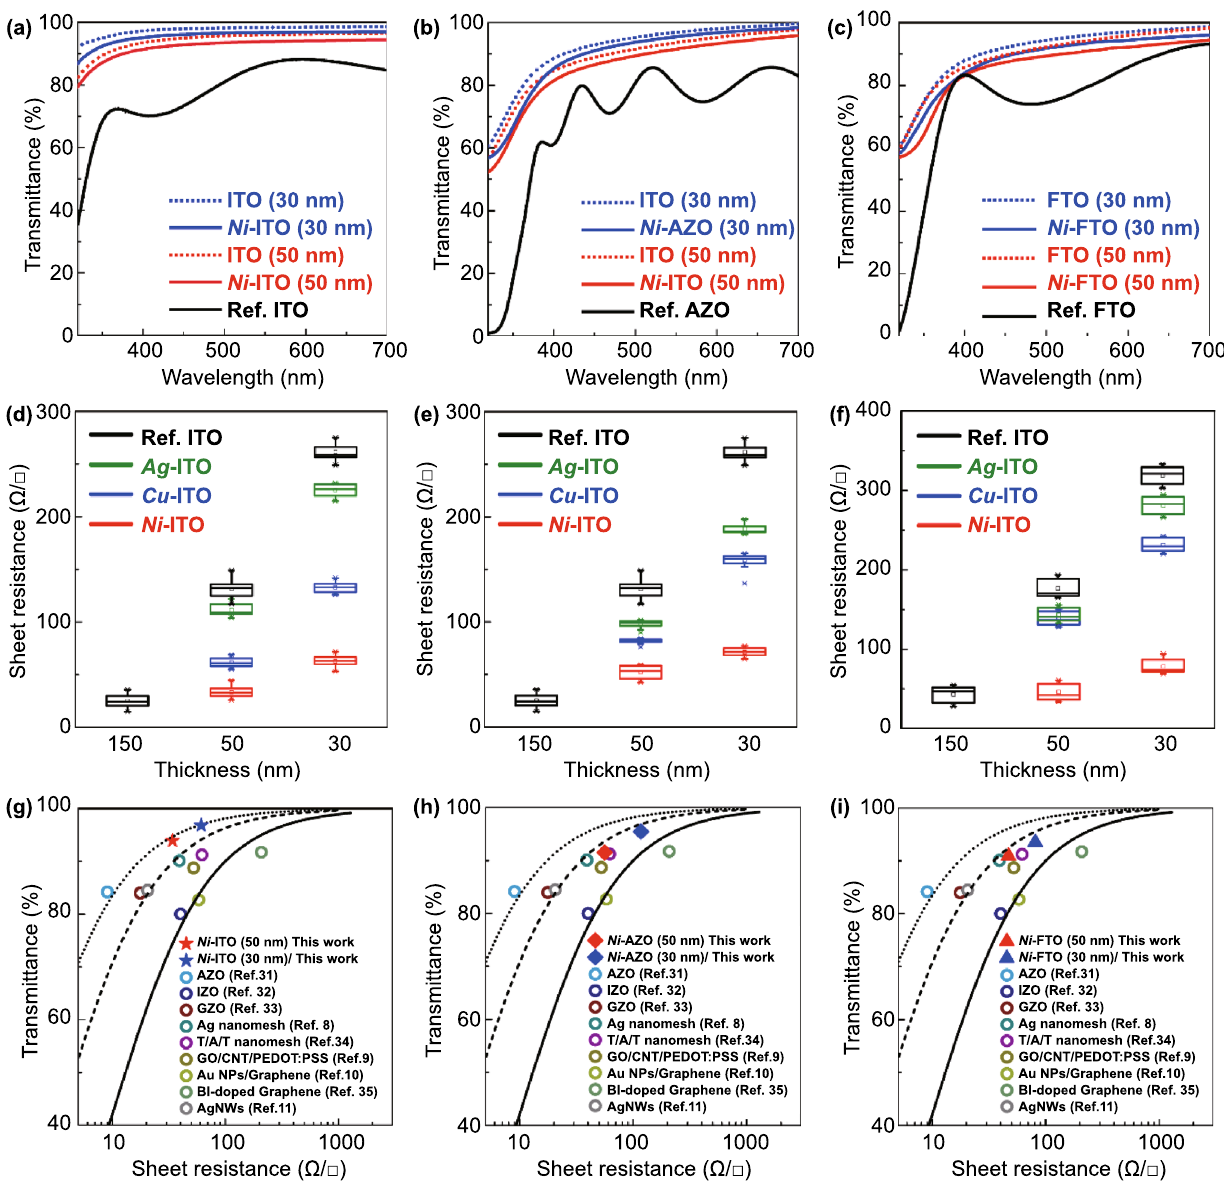
Fig. 2 Transmittance and R SH of m ‑TCOs: a–c Comparison of UV–visible transparency spectra of a Ni ‑ITO, b Ni ‑AZO, and c Ni ‑FTO. d–f R SH of d m ‑ITO, e m ‑AZO, and f FTO depending on the layer thickness. m is Ni (red), Ag (green), and Cu (blue). The black is the reference of each TCO. Transmittance (at 550 nm) as a function of R SH of g m ‑ITO (solid star symbols), h m ‑AZO (solid rhombus symbols), and i m ‑FTO (solid triangle symbols) samples alongside other reference samples. A series of solid and dotted lines represent curves calculated using the Tinkham equation corresponding to σOp/σDC values of 43 (solid line; minimum industry standard), 100 (dash line), and 200 (dotted